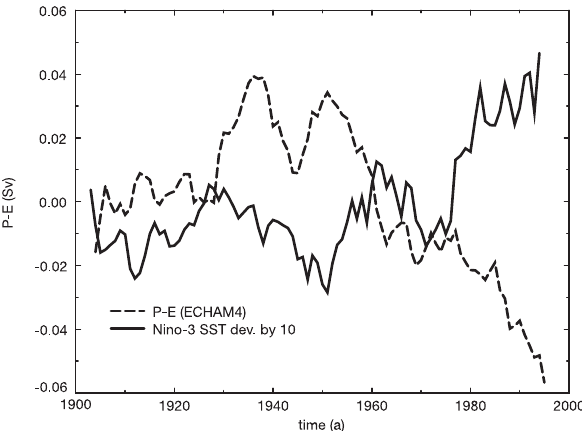
Fig. 5. Time series of the Niño-3 SST anomaly and the anomalous tropical Atlantic freshwater flux as simulated by the ECHAM4 model averaged over the region 10 ° S-30 ° N, which is the region with the most consistent response over the Atlantic. Both time series vary out of phase and exhibit strong trends during the last 50 years. Both time series were filtered with a 11- year running mean.